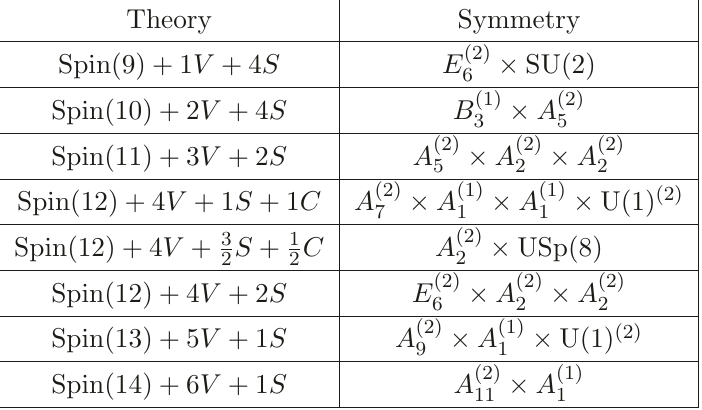
Table 1 . The minimal symmetry consistent with the perturbative plus 1-instanton contribution for the 5 d Spin gauge theories considered here. The spectrum of the expected additional current is such that it can only be accommodated by an affine group, at least for some factors of the global symmetry. This is interpreted as the theory lifting to a 6 d SCFT in the infinite coupling limit, whose symmetry is the finite Lie group associated with the affine case. The superscript here denotes whether the affine group is the twisted (2) or the untwisted version (1). This lifts to whether the compactification of the 6 d SCFT involves a twist or not. We also use the notation of U(1) (2) for a U(1) group projected out by charge